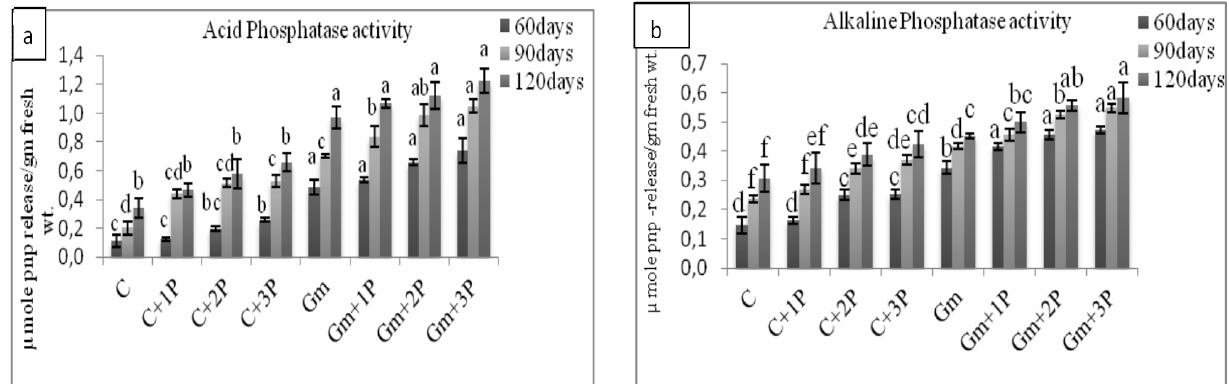
Fig. 2. Acid and alkaline phosphatase activity of Solanum melongena L. after 60, 90 and 120 days of AM